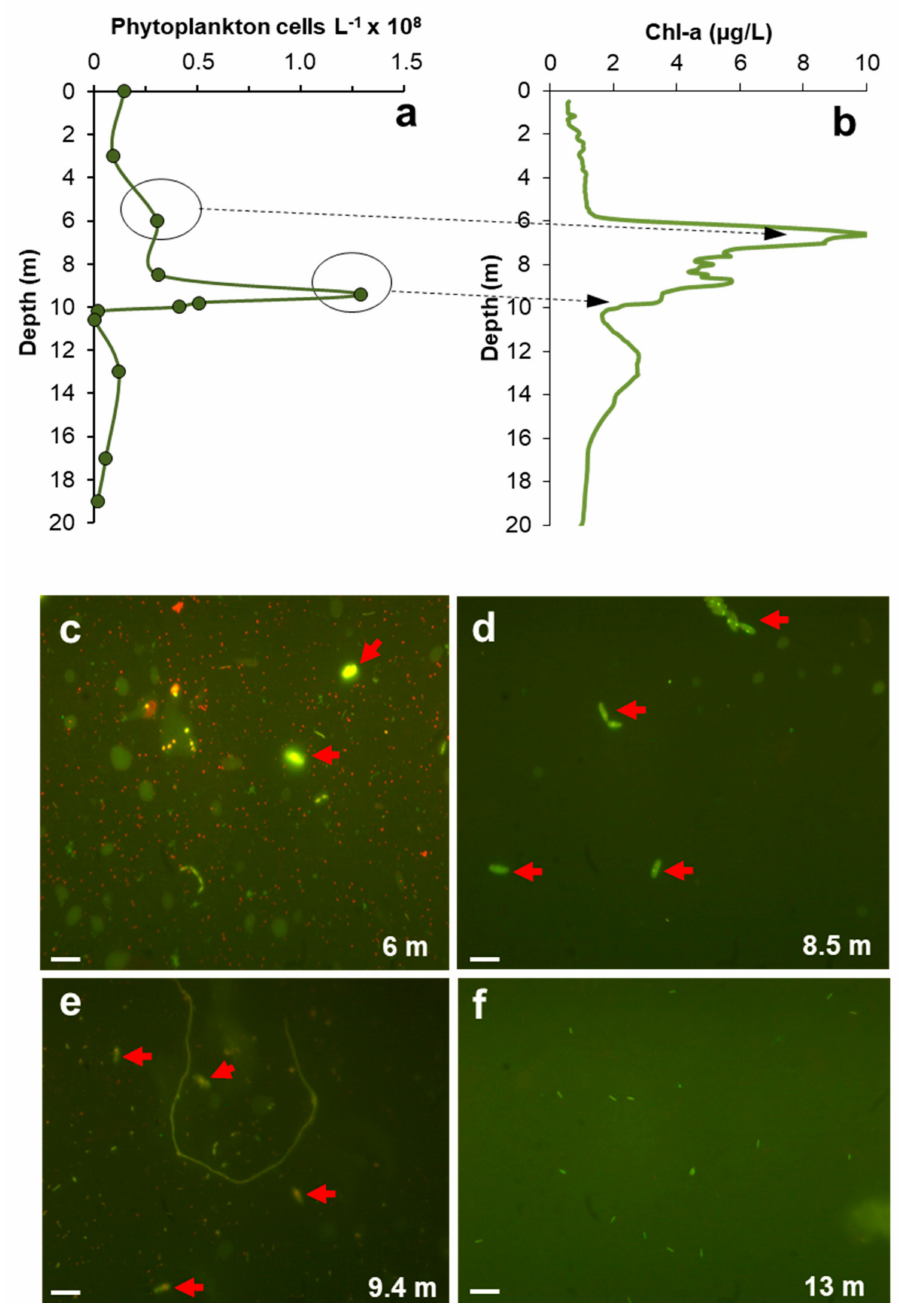
Figure 7. Vertical profiles of phytoplankton cell counts ( a ) and Chl-a concentration ( b ), and sequence of epifluorescence microscope images ( c – f ) showing the fluorescence intensity of phytoplanktonic cells ( c – e ; red arrows) and bacteria ( f ) at di ff erent depths in CM in September 2011. The scale bar in c–f represents 10 µ